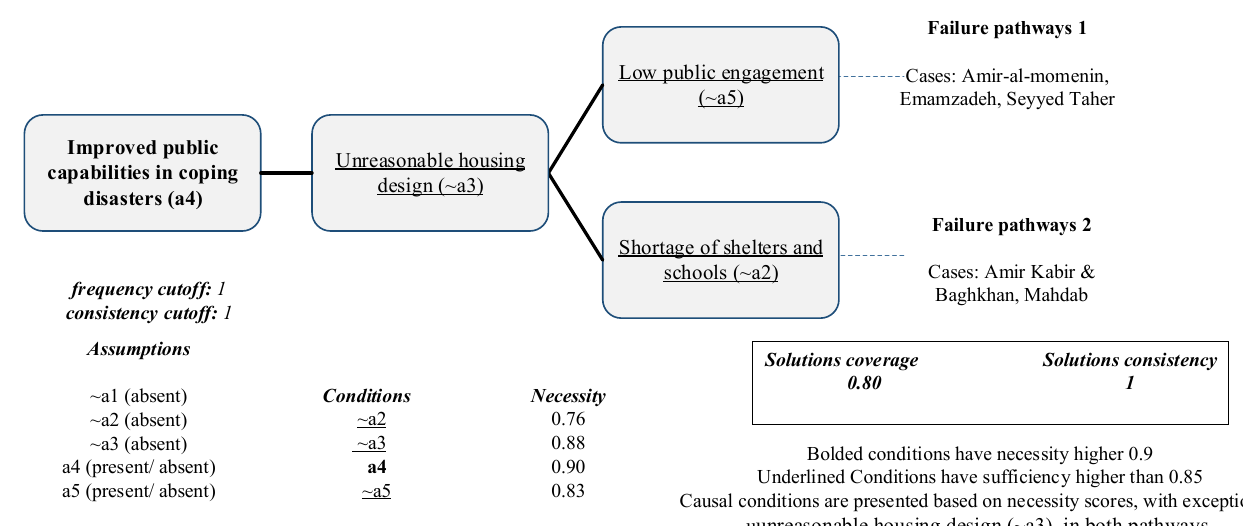
Figure 10. Pathways to failure of the ultimate outcome. Figure 9. Pathways to failure of the ultimate